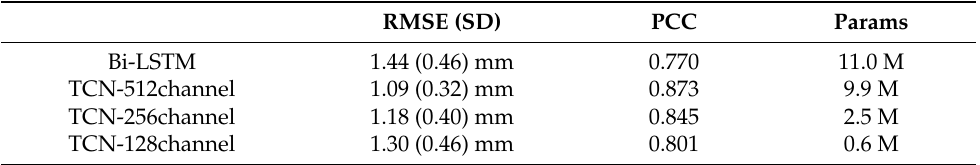
Table 1. Comparison between proposed TCN-based AAI model with different channel number and Bi-LSTM baseline model. The TCN model outperformed the baseline with much fewer parameters. RMSE (SD) PCC Params Bi-LSTM 1.44 (0.46) mm 0.770 11.0 M TCN-512channel 1.09 (0.32) mm 0.873 9.9 M TCN-256channel 1.18 (0.40) mm 0.845 2.5 M TCN-128channel 1.30 (0.46) mm 0.801 0.6 M Bi-LSTM baseline model achieves 1.44 mm mean RMSE with 0.46 standard deviation